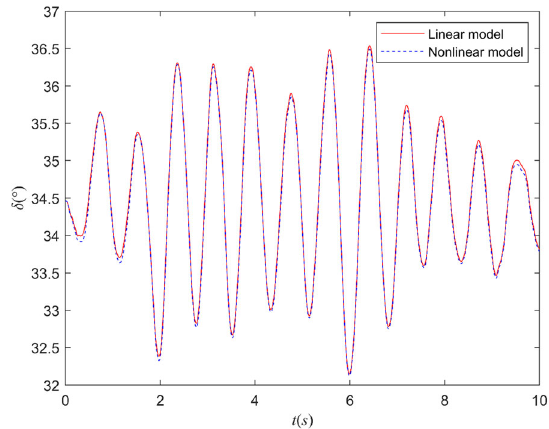
Fig. 2 Comparison of power angle curves between linear and nonlinear models of the system ( σ = 0.234)